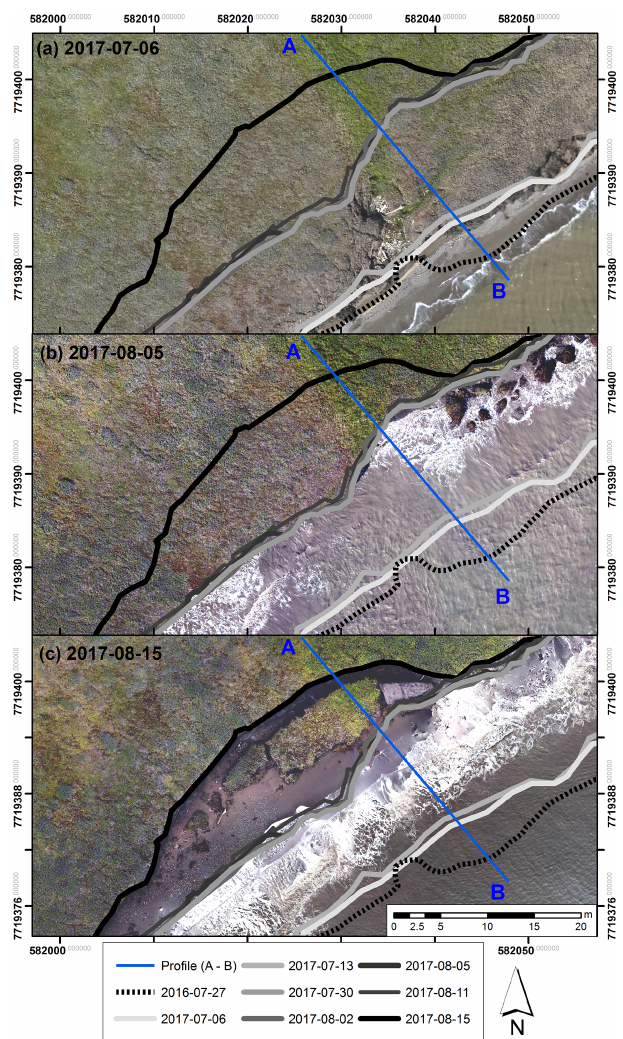
Figure 3. Shoreline positions between 2016 and 2017 overlaid on three orthomosaics for part of the study reach. The blocks shown in (c) were detached from the bluff, with water moving freely be- hind during periods of higher water level (see Fig. S3). Profile A–B indicates the horizontal position of the cross-sectional profiles dis- cussed in Sect. 4.2 and depicted in Fig.